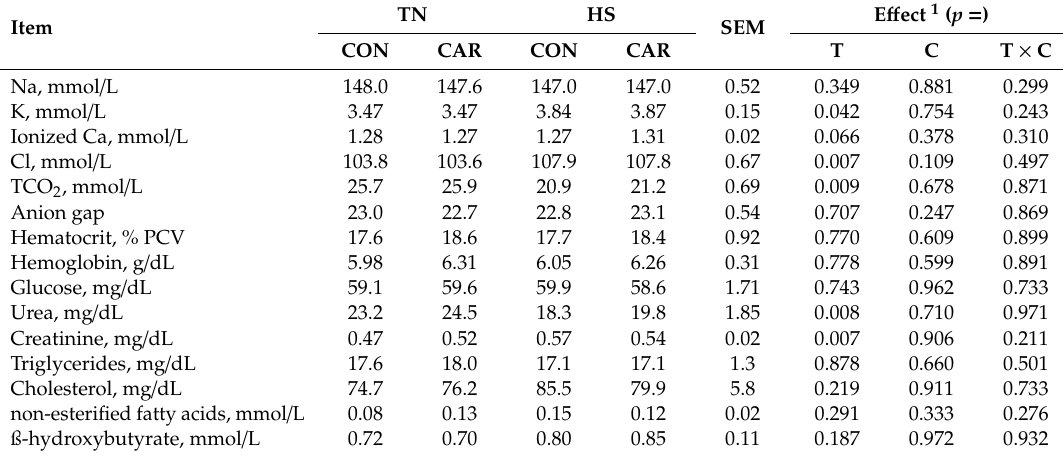
Table 5. Least squares means for blood metabolites in dairy goats under thermo-neutral (TN) or heat stress (HS) conditions. In each ambient temperature, goats were fed a control diet (CON) or supplemented with 1g L-carnitine